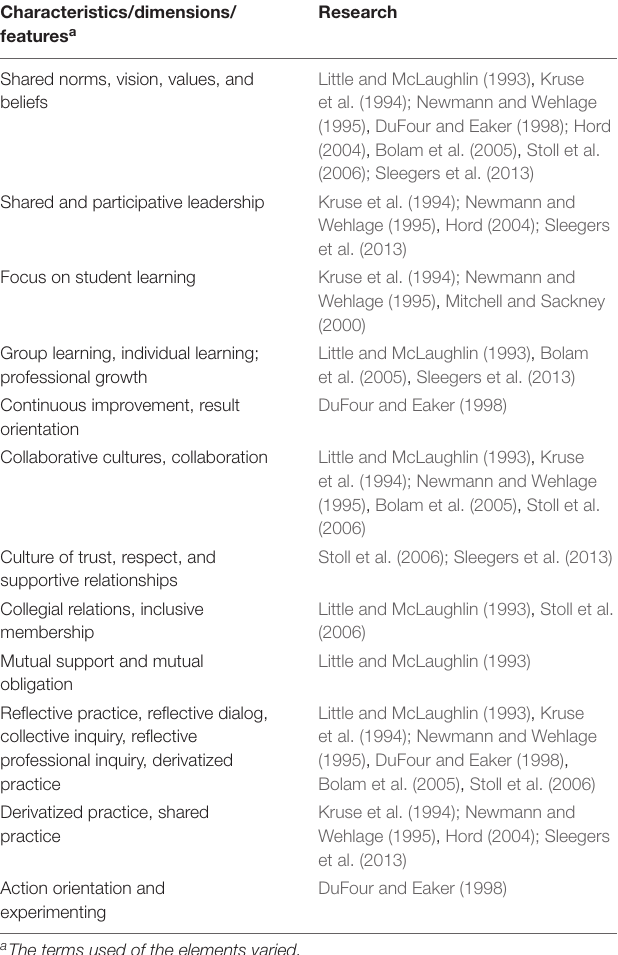
TABLE 1 | Characteristics of professional learning